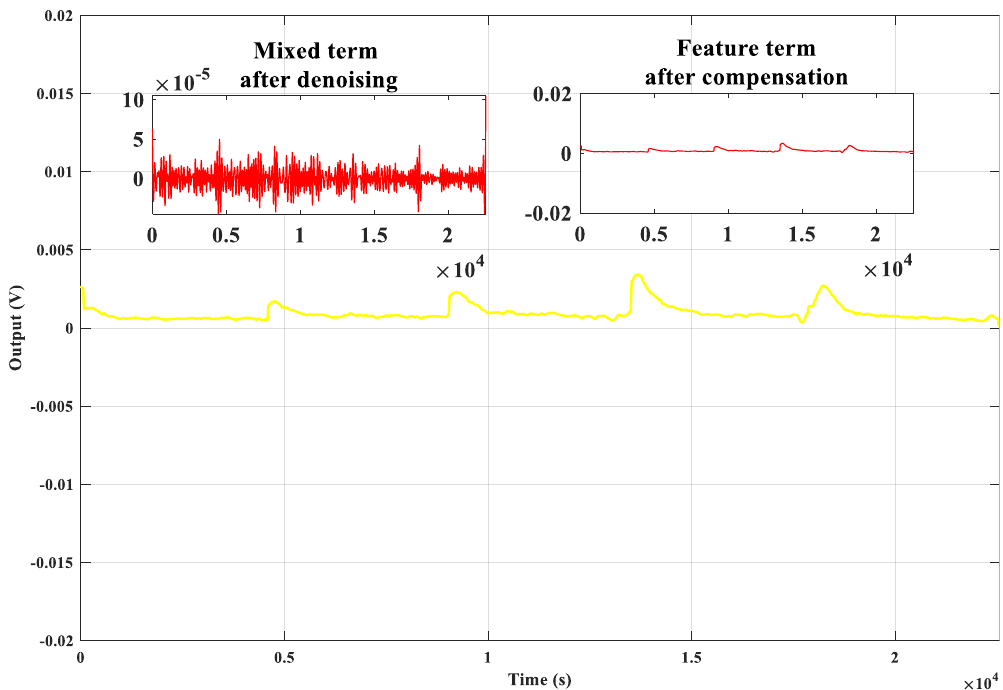
Figure 15. Comparison between Original signal and Denoising signal.